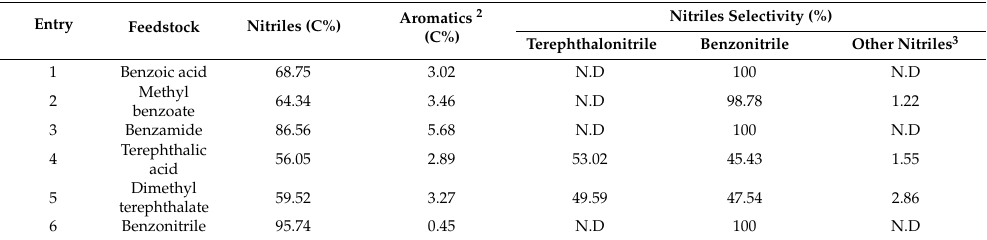
Table 5. Summary of catalytic fast pyrolysis with ammonia (CFP-A) of model chemicals over 4% Ca(OH) 2 / Al 2 O 3 at 650 ◦ C.